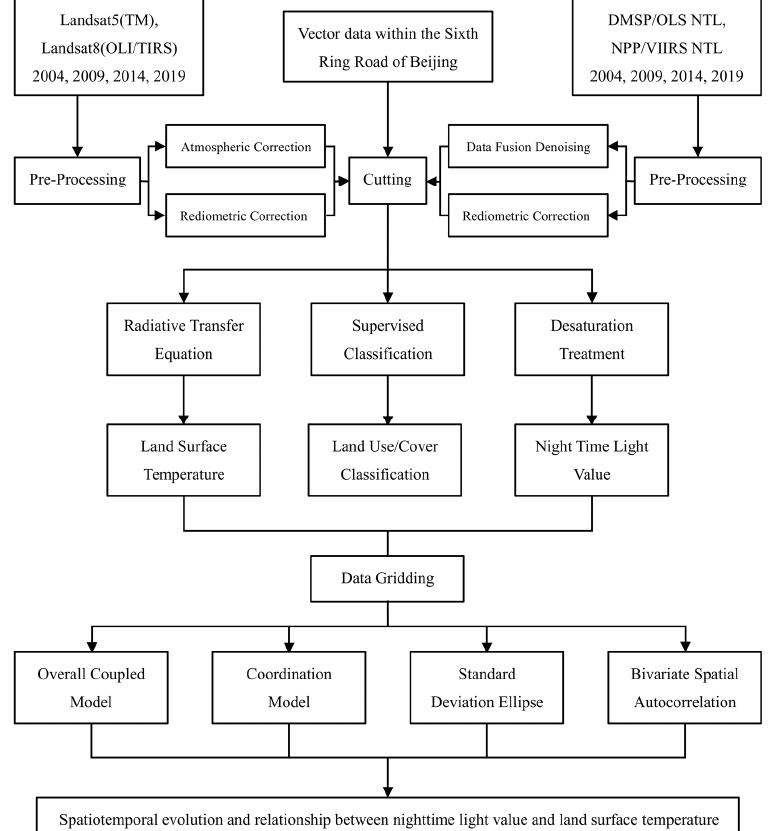
Figure 2. Flow chart of the methodological.